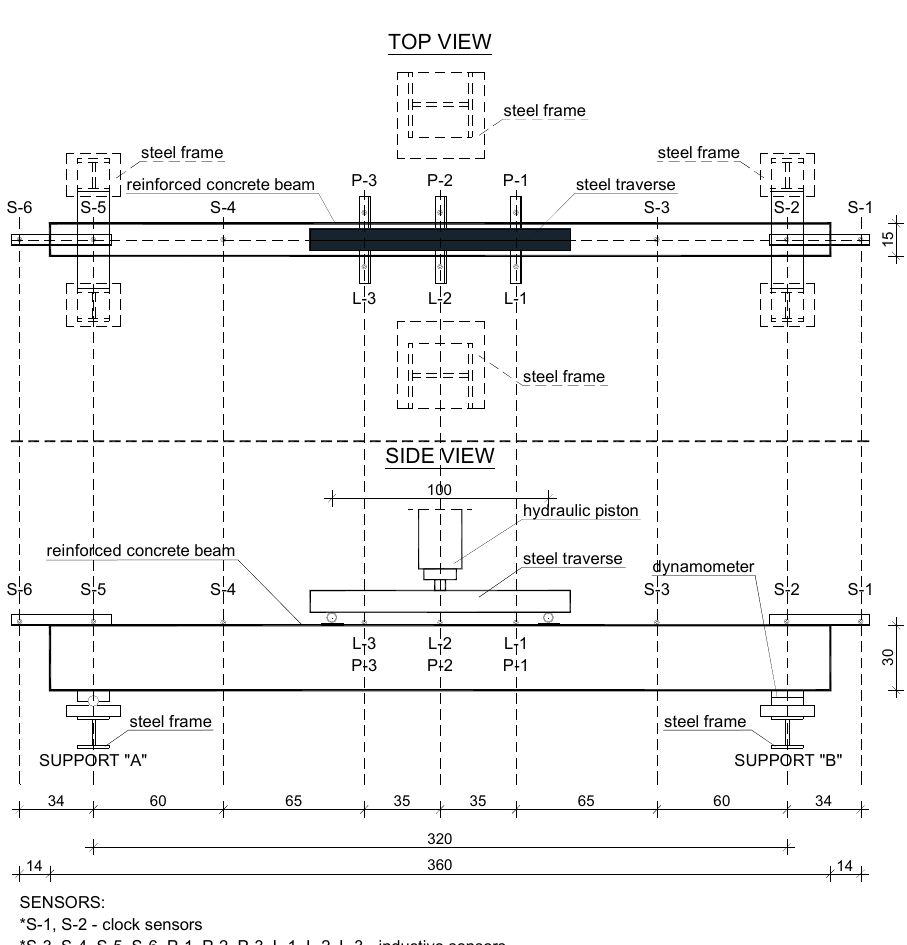
Figure 7. The test stand for testing RC beams.